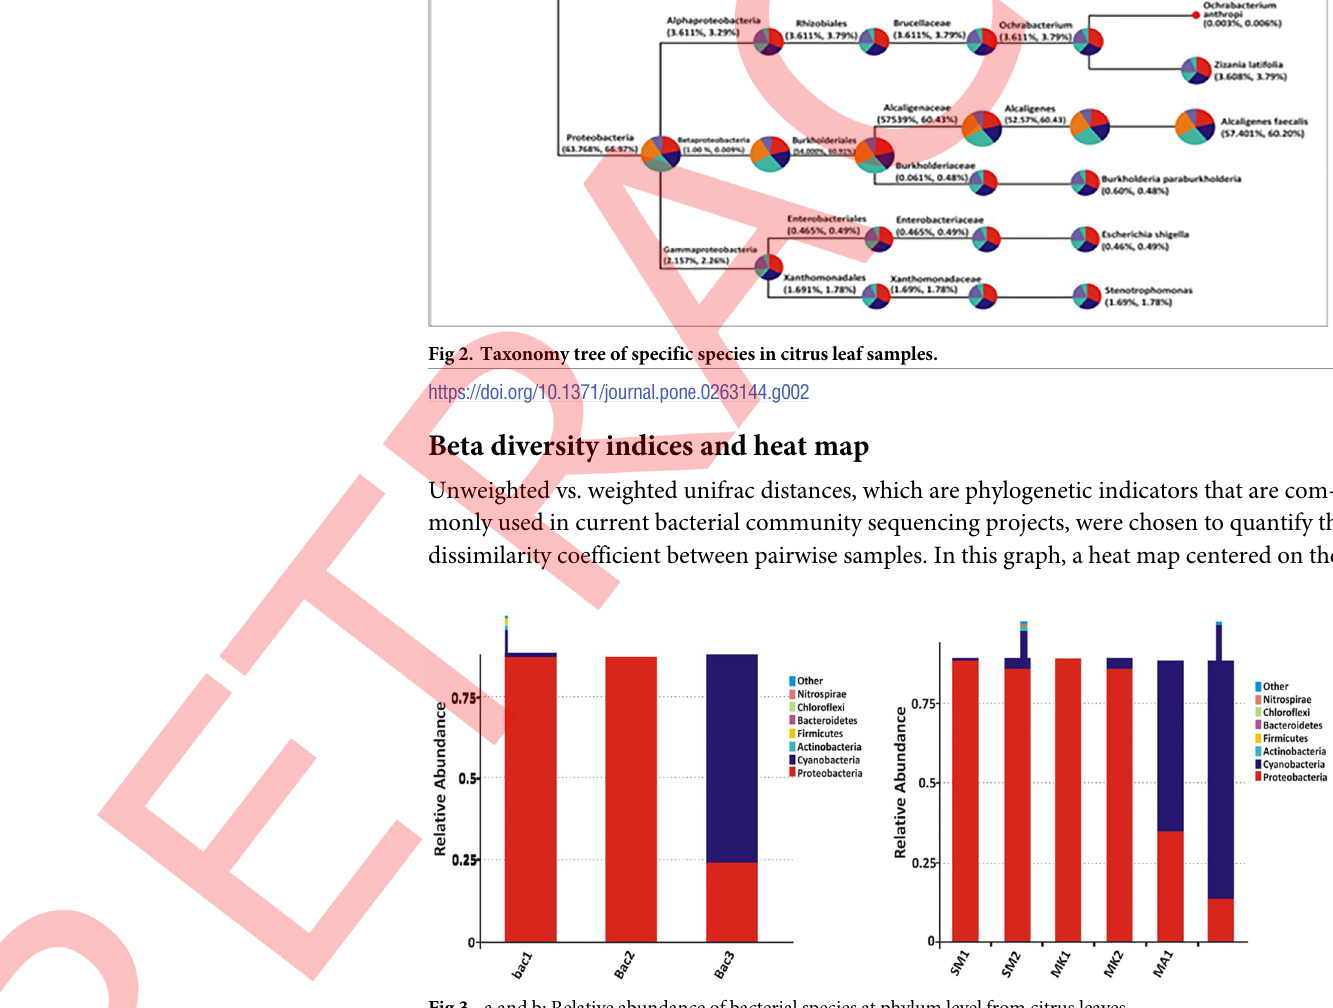
Fig 3. a and b: Relative abundance of bacterial species at phylum level from citrus